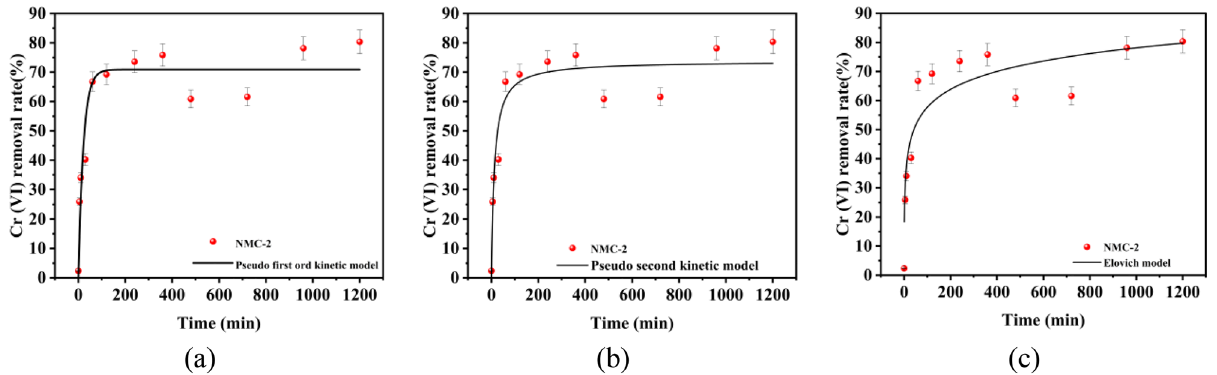
Figure 5. Adsorption influence factor test: ( a ) Pseudo first order dynamics model, ( b ) Pseudo second order dynamics model, ( c ) Elovich dynamics